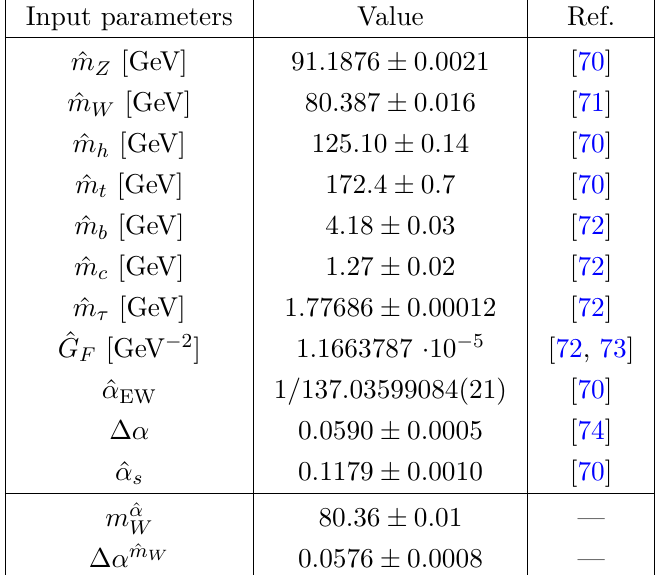
— is the value of m W inferred in the W